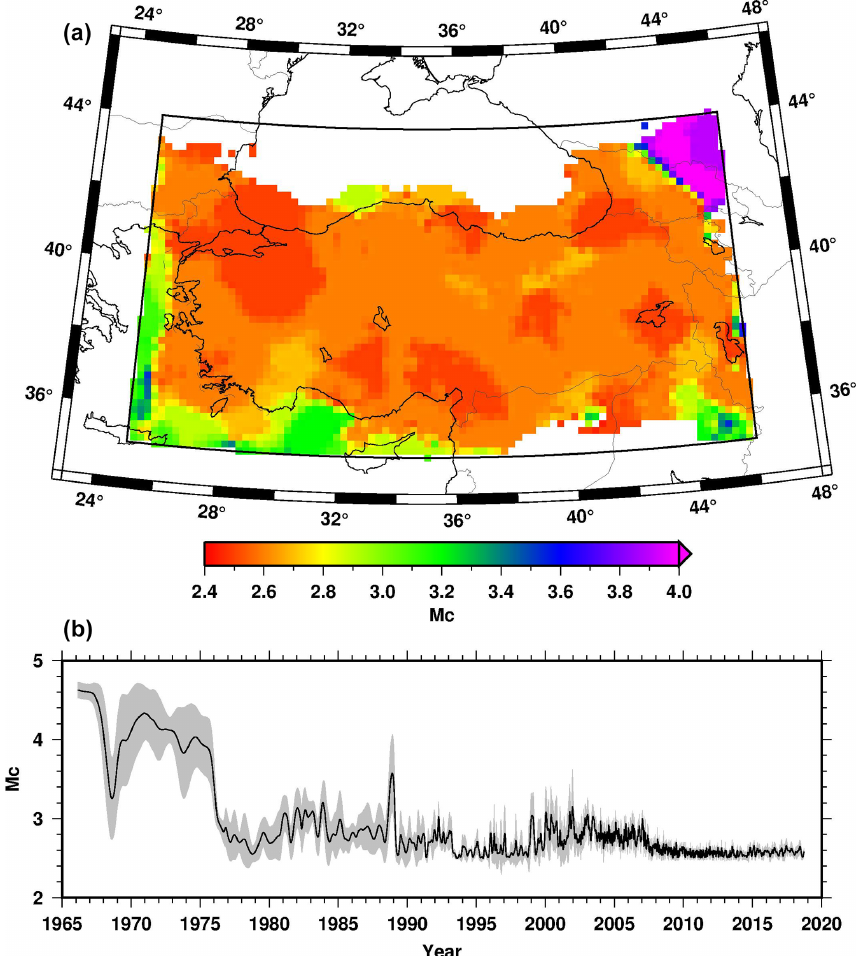
Figure 8. (a) M c spatial distribution map for the events since 1964. There are no data in white areas. (b) Temporal M c variation as a function of year. Grey area is the ± σ interval estimated by